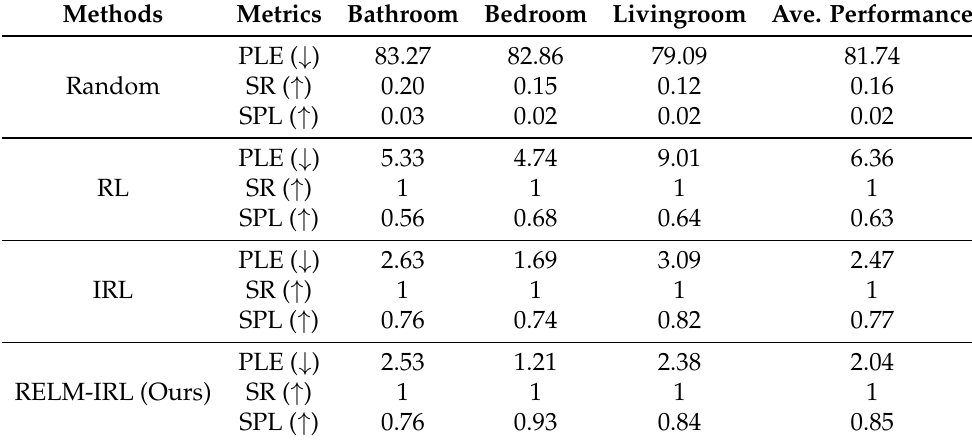
Table 1. Quantitative results on trained targets on Task (I). For SR and SPL, higher values represent a better performance. In contrast, lower values represent a better performance in PLE. The best results for individual scenes and the best average results across all scenes are shown in blue and red,